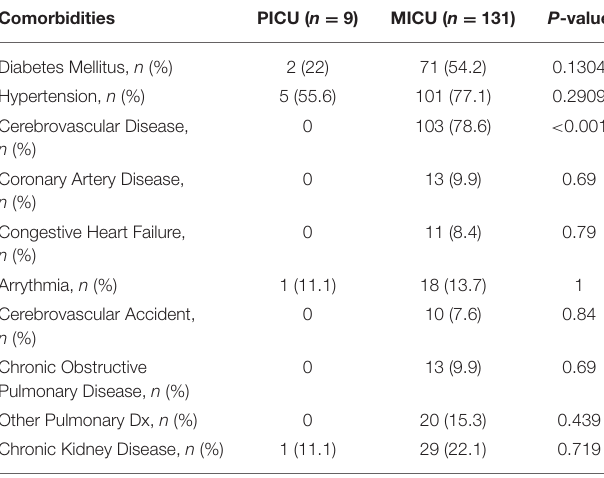
TABLE 2 | Comorbidity comparison between adult patients in the PICU and MICU.